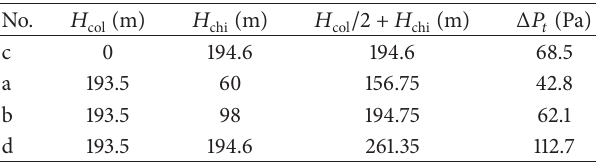
Table 4: Collector and chimney heights of the four